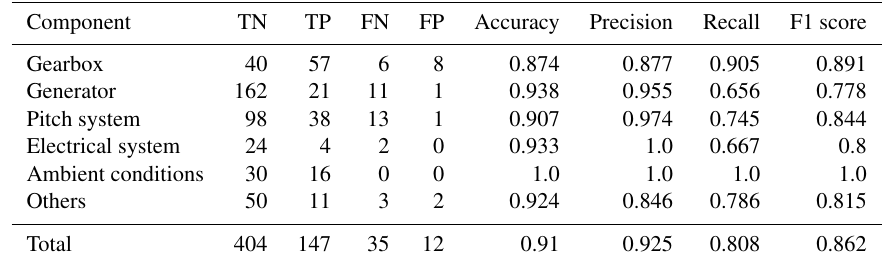
Figure 7. Validation F1 score and accuracy for different hyperparameter configurations on 2-year and 1-year signals. Table 1. Automated training data validation results per component for best configuration (Laplace/batch-SD/ α cost = 145) on 2-year